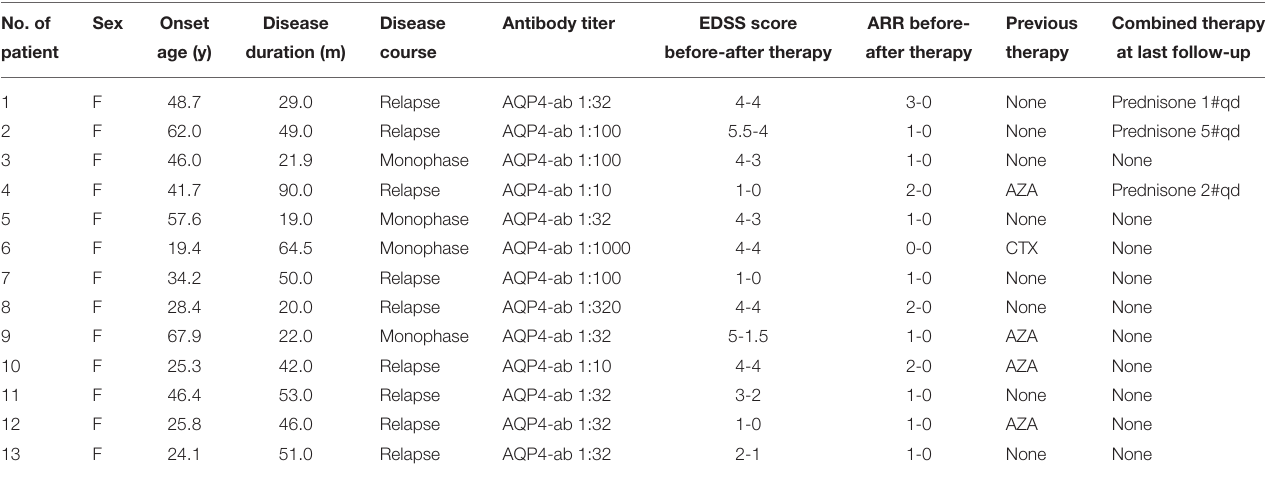
TABLE 2 | Demographic and clinical characteristics of patients with NMOSD taking TAC. No.